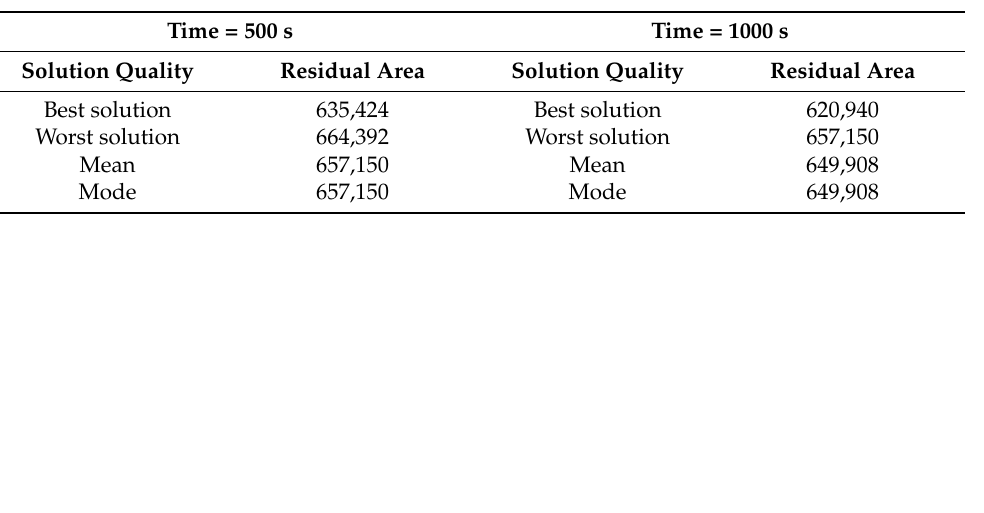
Table 4. ILS behavior with different execution times (residual area).